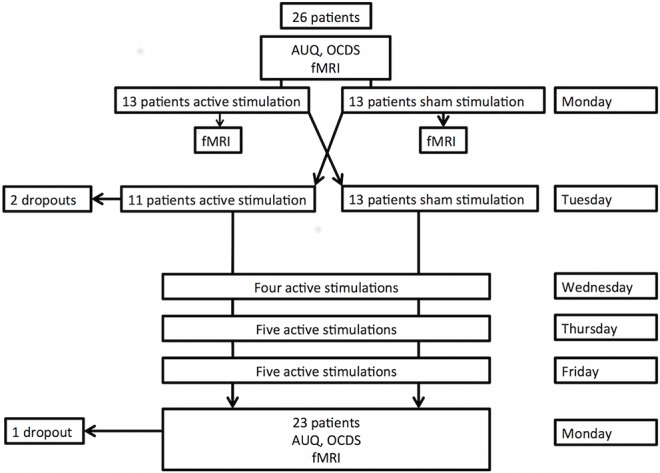
Flowchart of the HF-rTMS treated patients through the study.